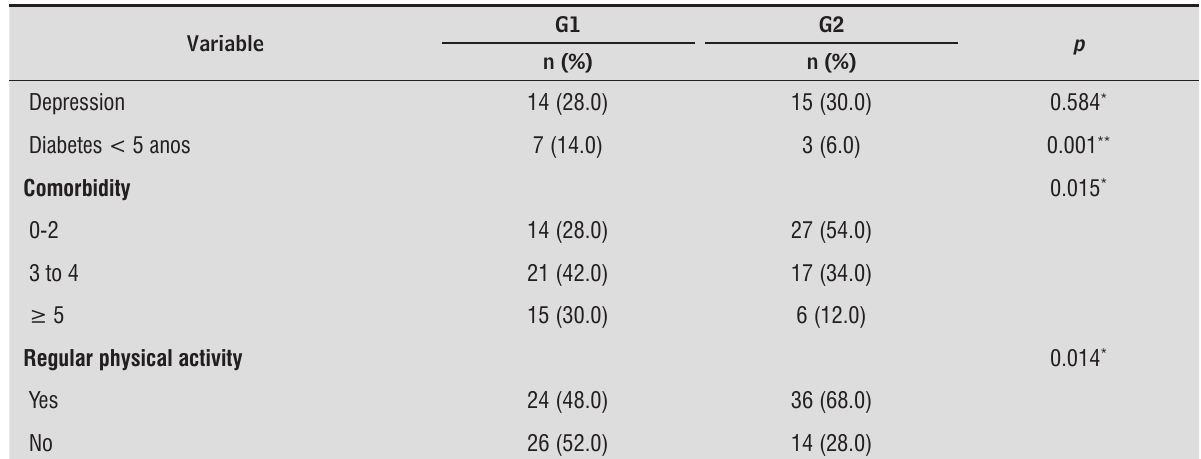
Table 1 - Contextual factors for the elderly from G1 and G2